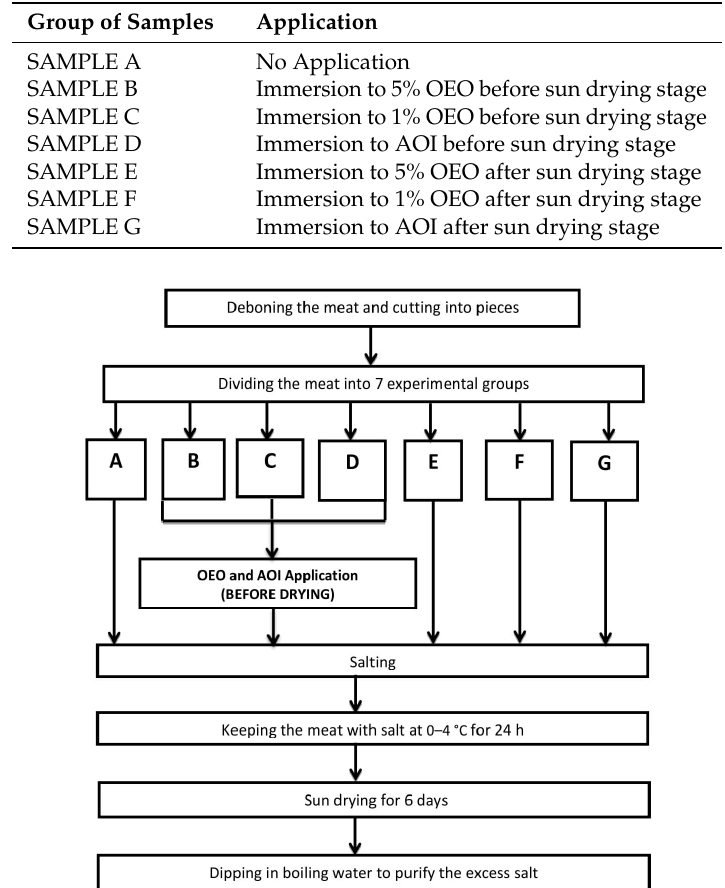
Table 1. Sample codes of the study. OEO: oregano essential oil; AOI: aqueous oregano infusion.